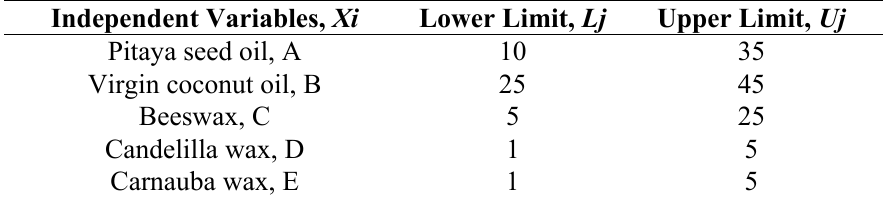
Table 5. Constraints of the independent variable